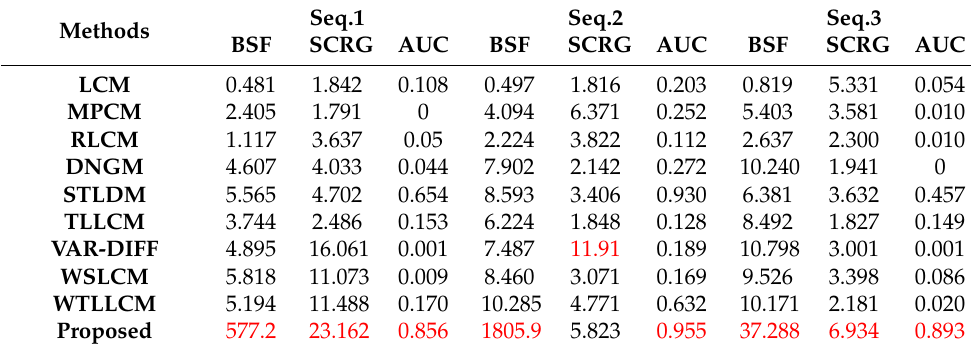
Table 3. Measurements for ten detection methods.